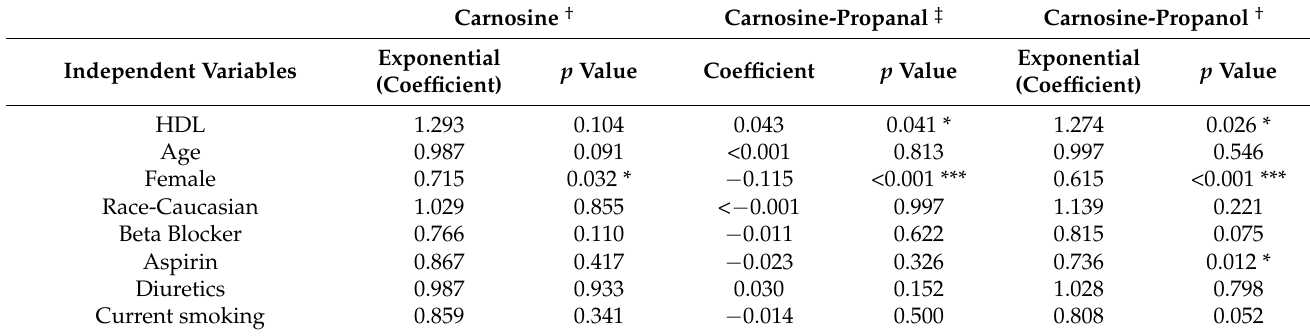
Table 5. Association of Carnosine, Carnosine-Propanal, and Carnosine-Propanol with HDL. Carnosine †